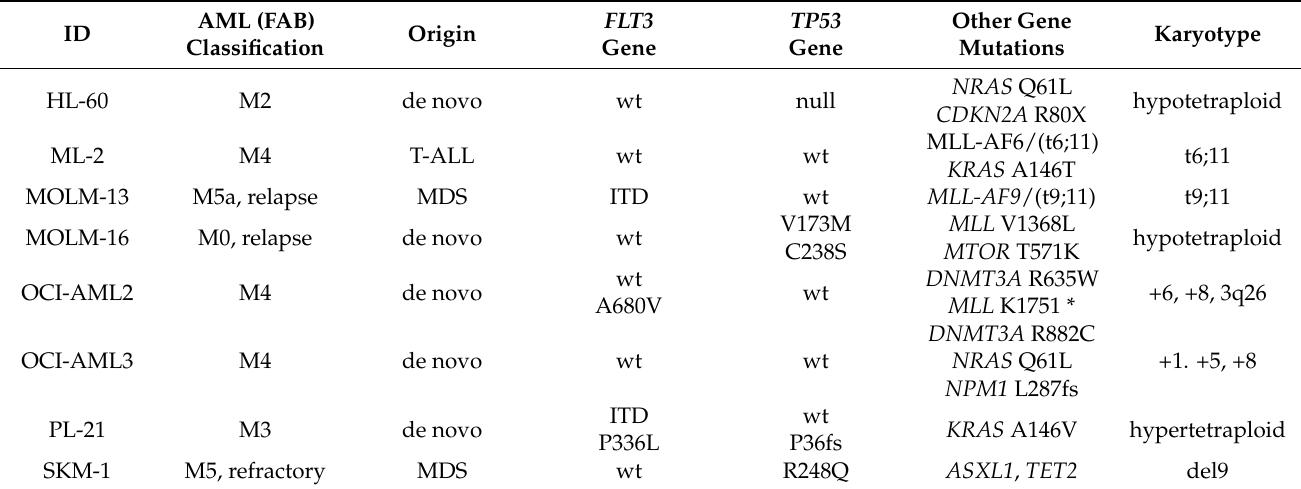
Table 1. Genetic variants in acute myeloid leukemia (AML) cell